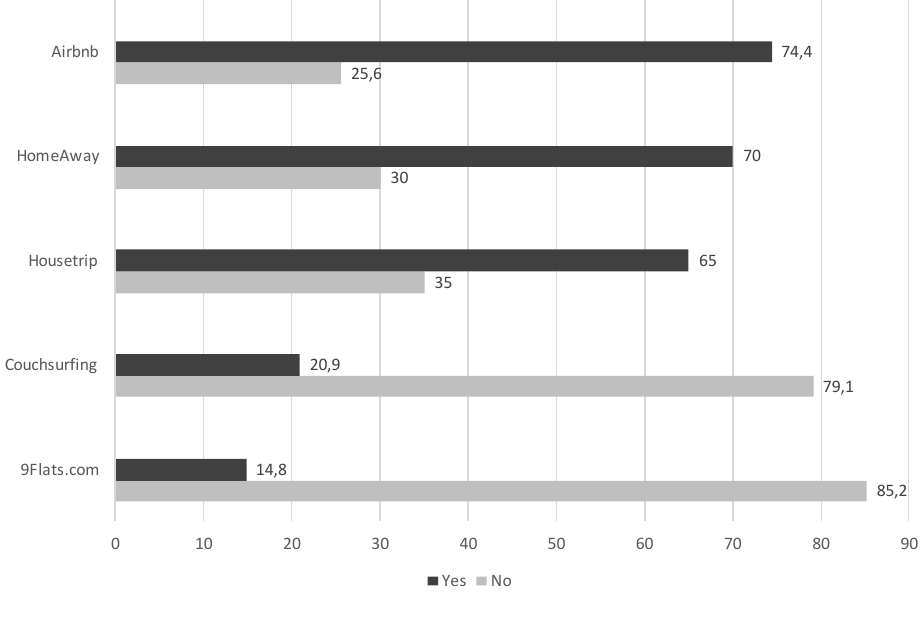
Table 3: Usage of